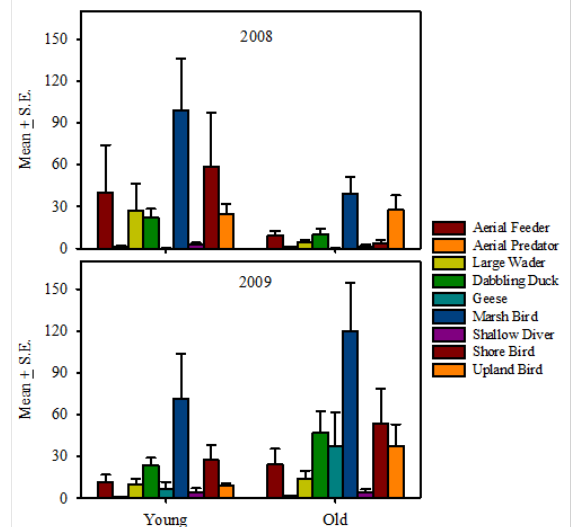
Figure 5. Average abundance of eight bird foraging guilds observed (wetland surveys) on wetland areas of Wetlands Reserve Program easements. 2008 includes Sacramento, San Joaquin, and Tulare sub-basin data, whereas 2009 includes Sacramento and San Joaquin sub-basin data only. ―Young‖ sites are ≤5 years since restoration; ―Old‖ are >5 years. Foraging guilds are comprised of species that share behavioral traits and have similar environmental requirements [13]. Standard error bars are